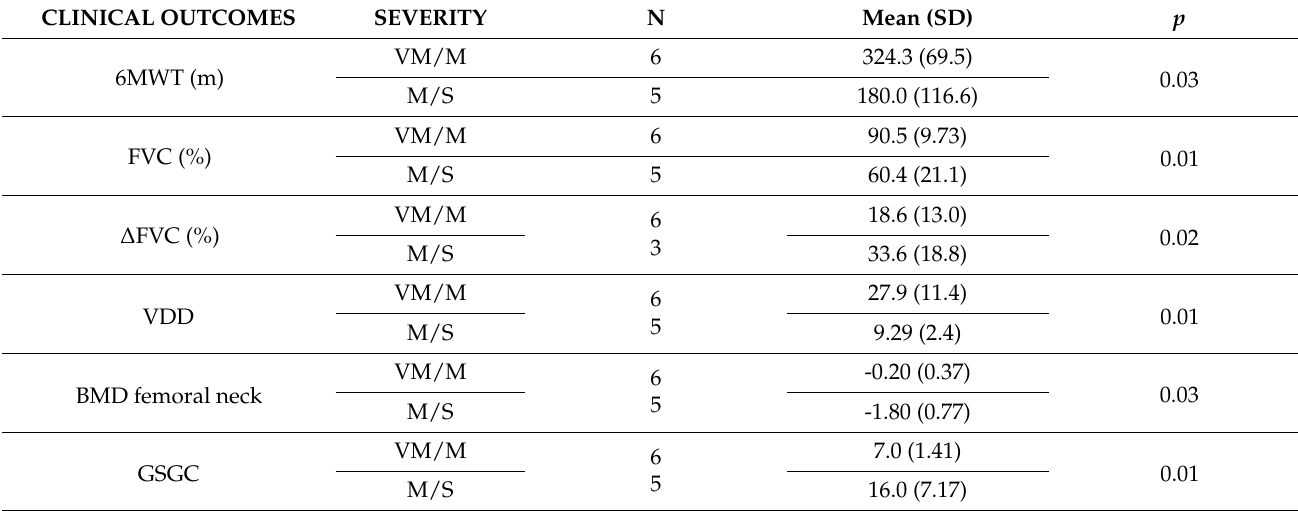
Table 3. Clinical variables associated with a higher severity index